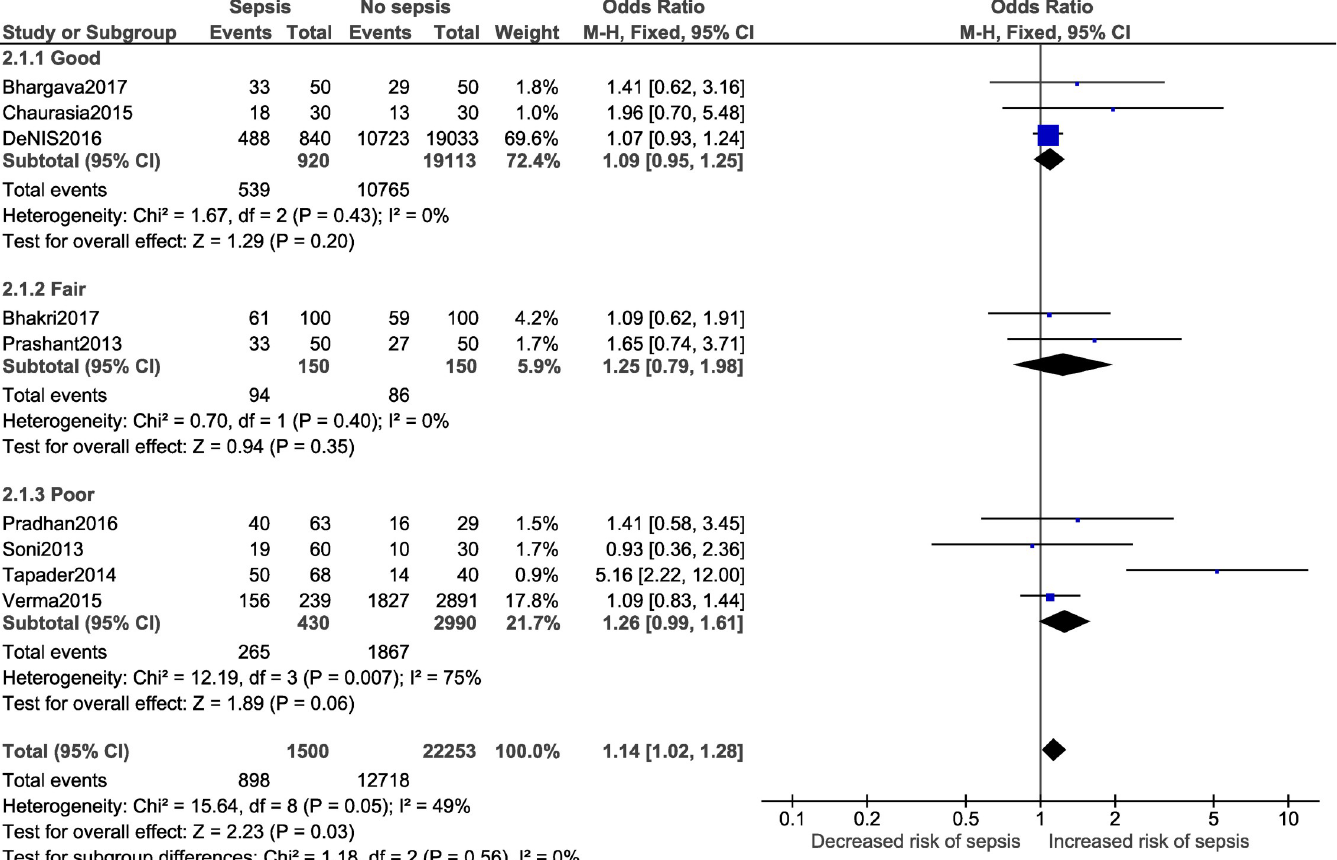
Fig 15. Forest plot showing random-effects meta-analysis of male neonates, with and without sepsis, sub-grouped by study quality (9 studies) [IV: Inverse Variance; CI: Confidence Interval].